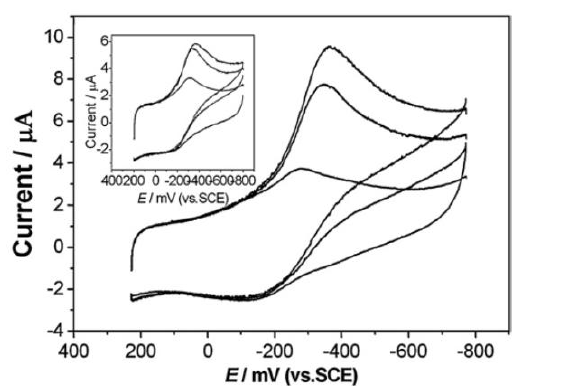
Figure 3. Cyclic voltammograms of HRP/TPSP-ZnO and HRP/spherical ZnO (inset) modified GCEs in 0.1 M PBS containing 0, 12 and 18 mM H at 100 mV s -1 . Reprinted from reference [29] with permission from The Royal Society of